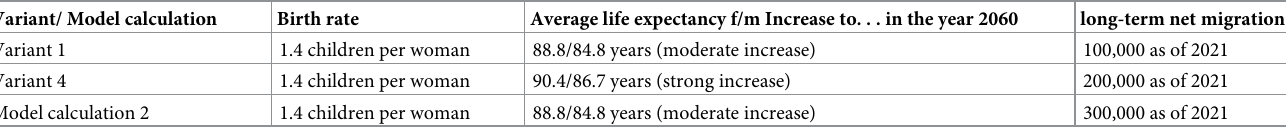
Table 2. Overview of the selected variants of the 13th coordinated population projection.